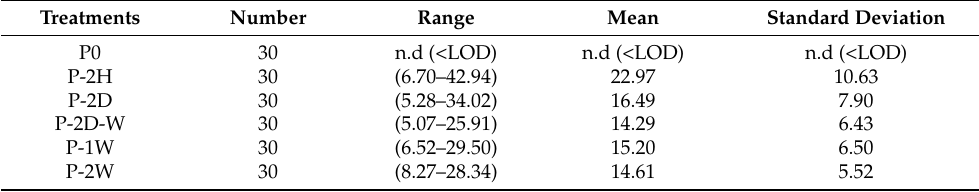
Table 4. Reference values of the content of profenofos (mg · kg − 1 ) for the